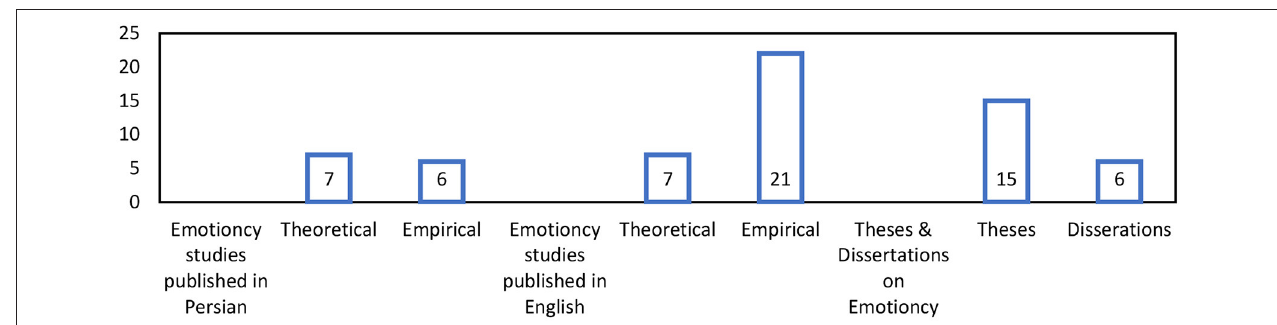
FIGURE 6 | Published emotioncy research